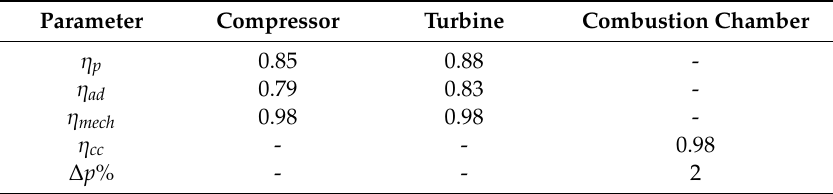
Figure 5. Cycle efficiency and specific work output as a function of turbine inlet temperatures (TIT) (PR = 30). 4. Results and Discussion A set of cycle simulations was performed varying both pressure ratios ( β max from 10 to 40) and turbine inlet temperatures ( TIT = 1473–2673 K) in order to analyze the air-cooled gas turbine cycle performance. Inlet cycle pressure and temperature were kept constant throughout ( p 0 = 1 bar, T 0 = 300 K). The values of the required cooling flow rates are shown in Figure 6a. Let us first analyze the effect of different coolant flowrates on the air-to-fuel ratio α . For a given PR , α decreases with increasing TIT, as shown in Figure 6b, for two reasons: (1) In order to reach higher temperatures, more fuel must be injected in the combustion chamber; (2) A higher air extraction rate from the HP compressor stages for cooling purposes, corresponds to a decrease of the air flowrate into the combustion chamber. Legenda: